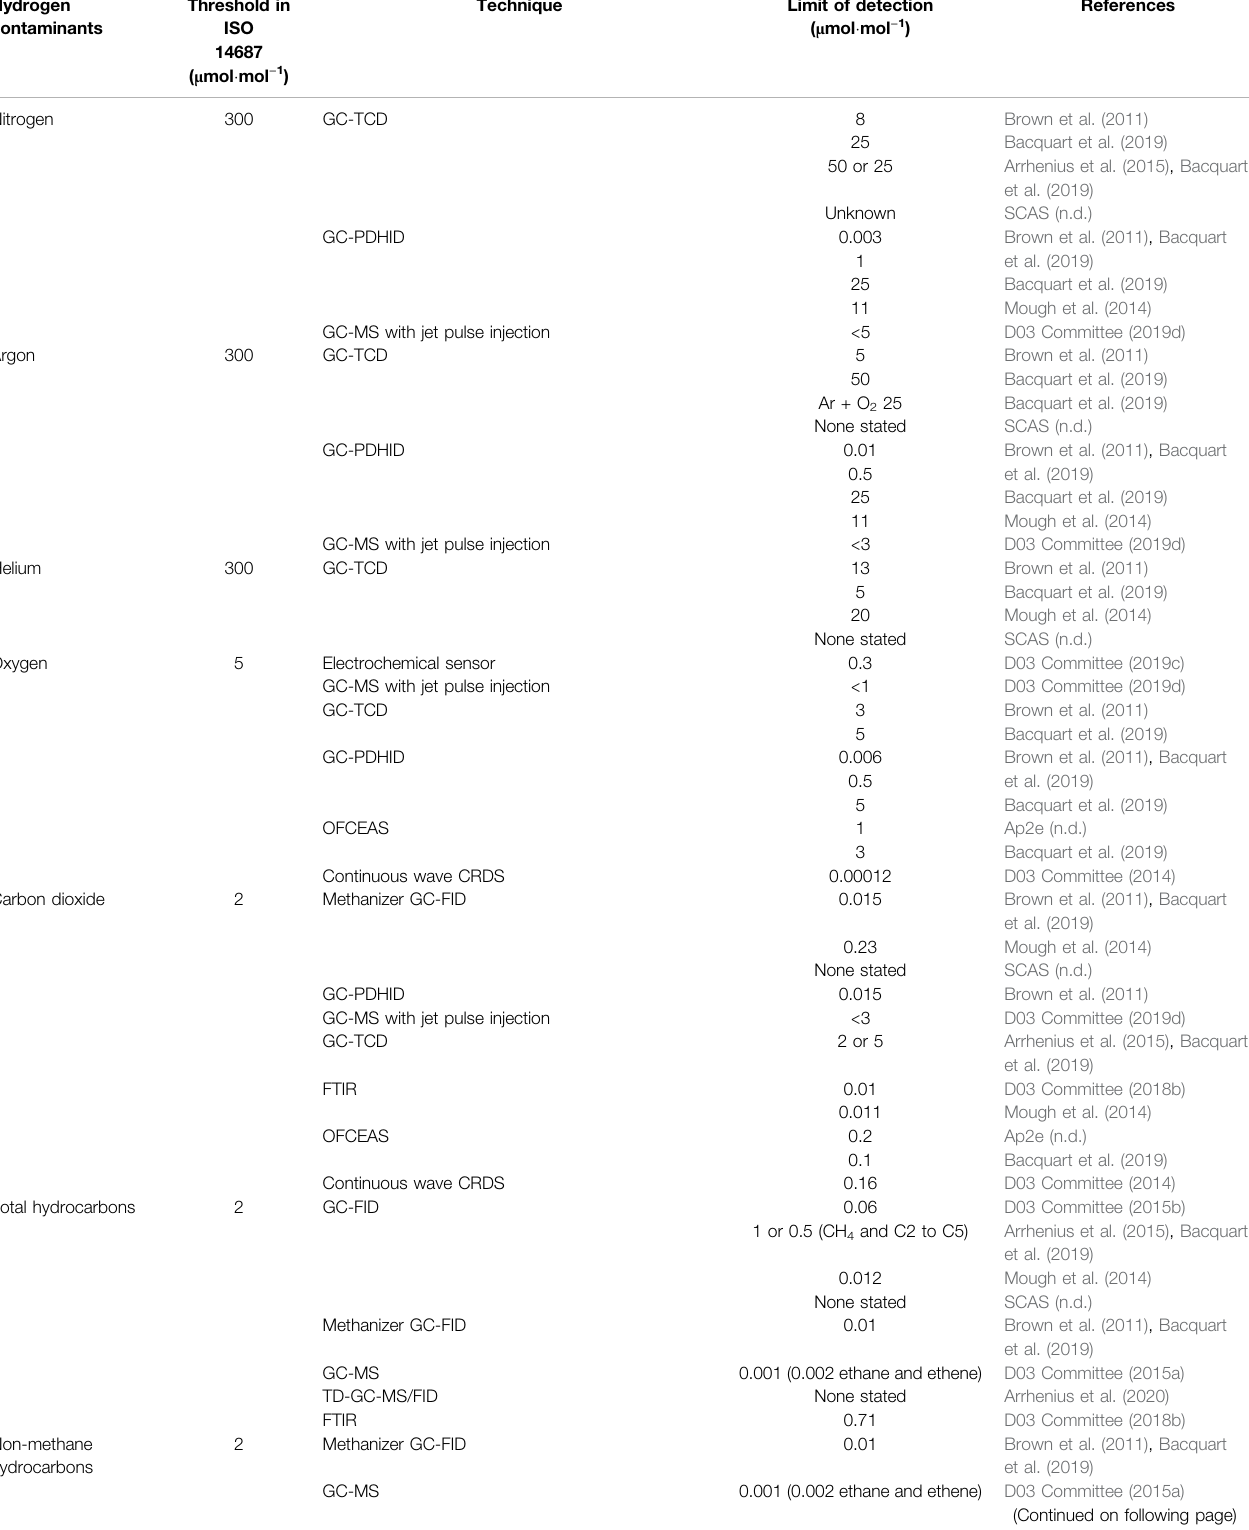
TABLE 10 | ( Continued ) Analytical methods from the bibliographical study per impurity with detection limit above the control